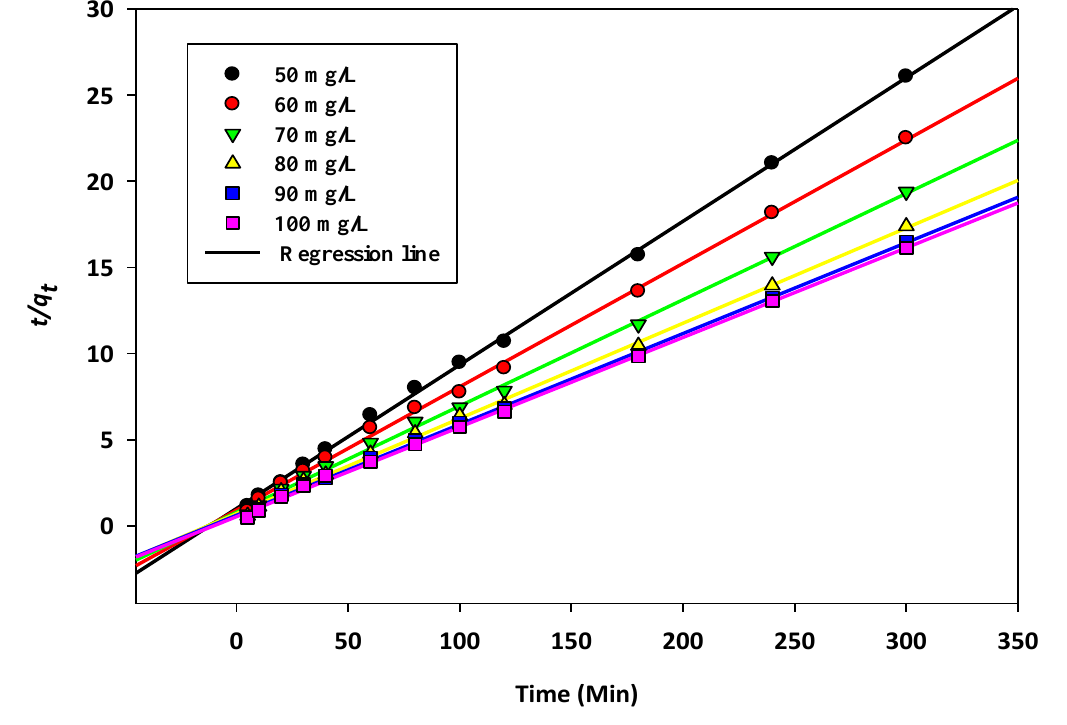
Figure 4. Pseudo second order kinetics of copper, Cu(II) cations sorption onto activated biochar.